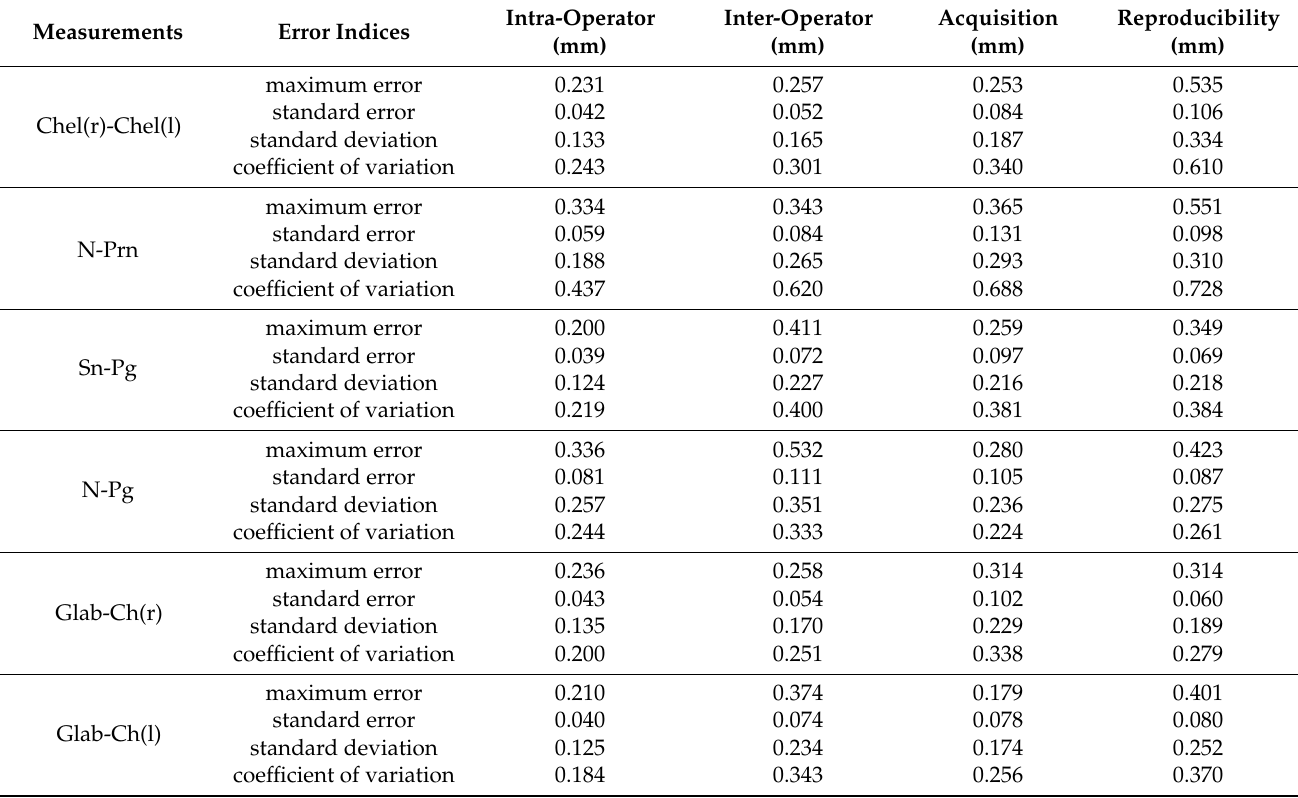
Table 2. Error magnitude statistics: the table shows the descriptive statistics used to quantify measurement error magnitude. Maximum error, standard deviation, standard error, and coefficient of variation were calculated for each distance between landmarks in investigating intra-operator, inter-operator, acquisition, and reproducibility error. All measures are expressed as